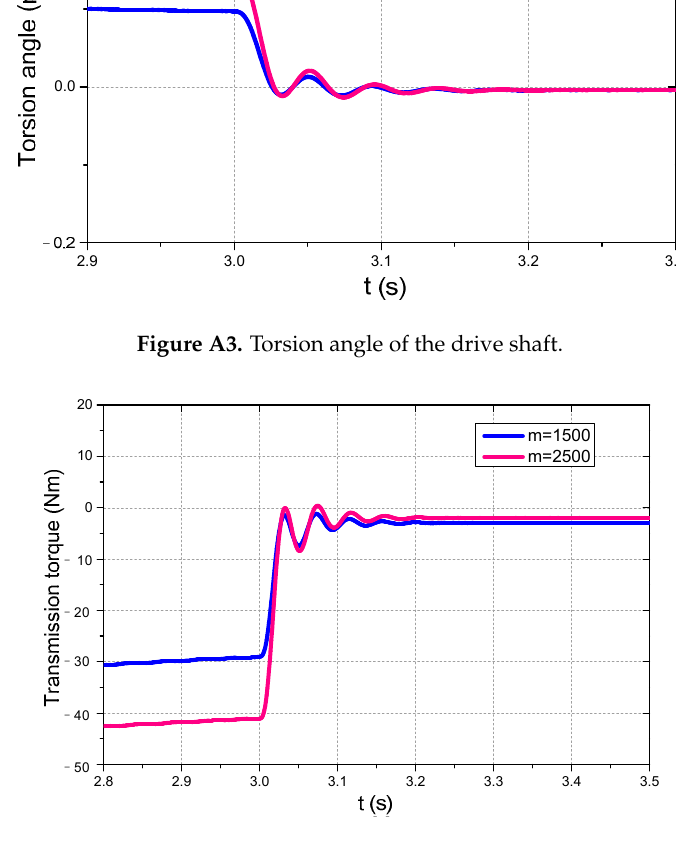
Figure A4. Transmission torque τ .